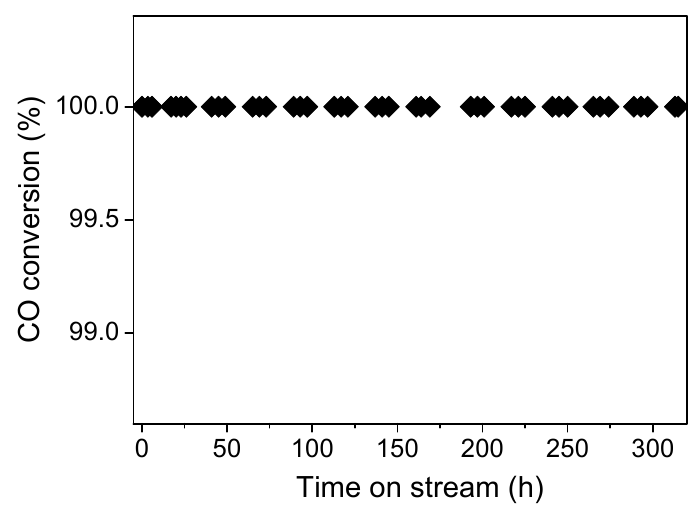
Figure 8. Conversion of CO over Au/FeOOH at ambient temperature with time on stream.